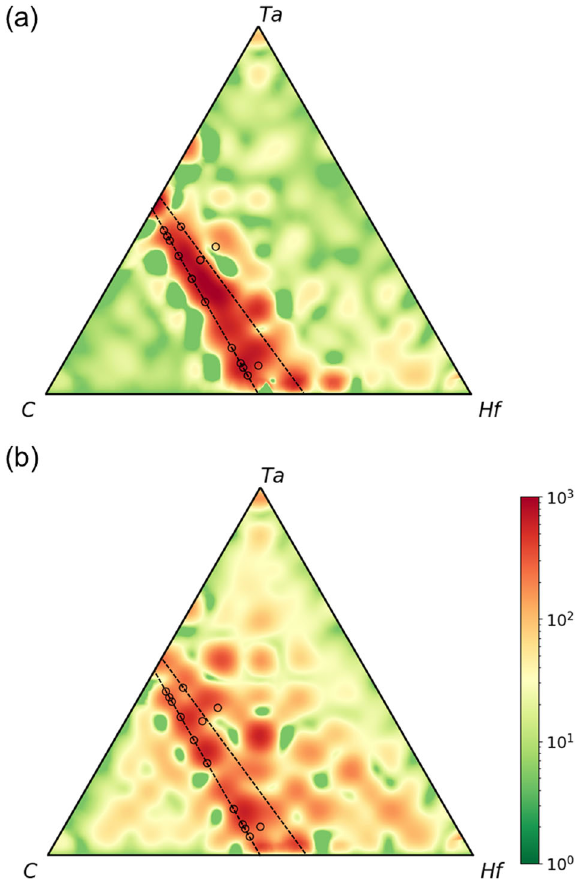
Fig. 9 Sampling intensity maps of the Hf – Ta – C system in chemical composition space. Data are generated from a COPEX and b USPEX. The map is colored according to the sampling intensity, divided into 23 × 20 bins, and the color bar refers to the number of sampled structures in each bin. The stable ternary compounds are marked by black